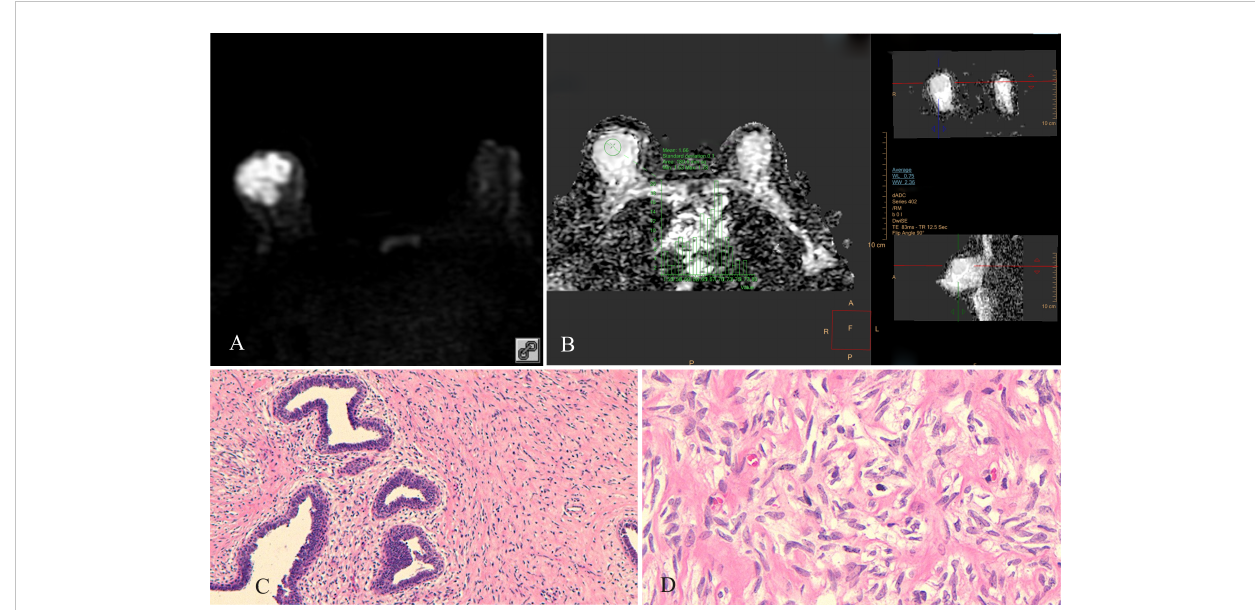
FIGURE 2 Borderline PT of the right breast, female, age 45 years. (A) DWI (b800 s/mm 2 ): mixed hyperintense signal; (B) ADC map: isointense signal, ADC mean = 1.66×10 − 3 mm 2 /s; (C) HE ×100: uneven distribution of tumor stromal cells, high cell density in some areas, low cell density in other areas; (D) HE ×400: tumor stromal cells had “ tadpole-like ” nuclei, cells were closely packed.